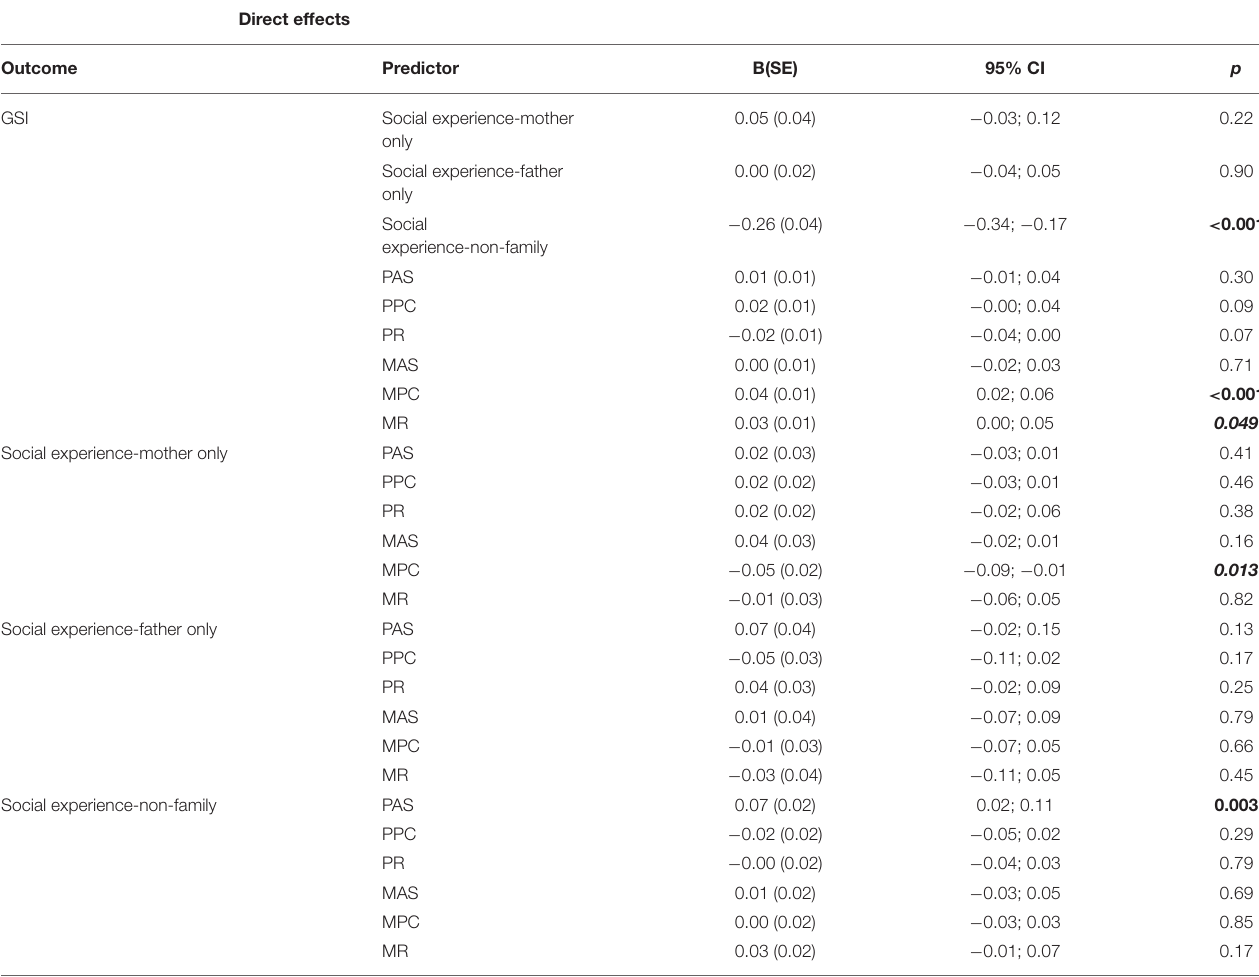
TABLE 4 | All standardized direct effects in the comprehensive, exploratory path model with parenting styles as six independent variables; three mediating variables of mean daily-life social experience; and one outcome variable of